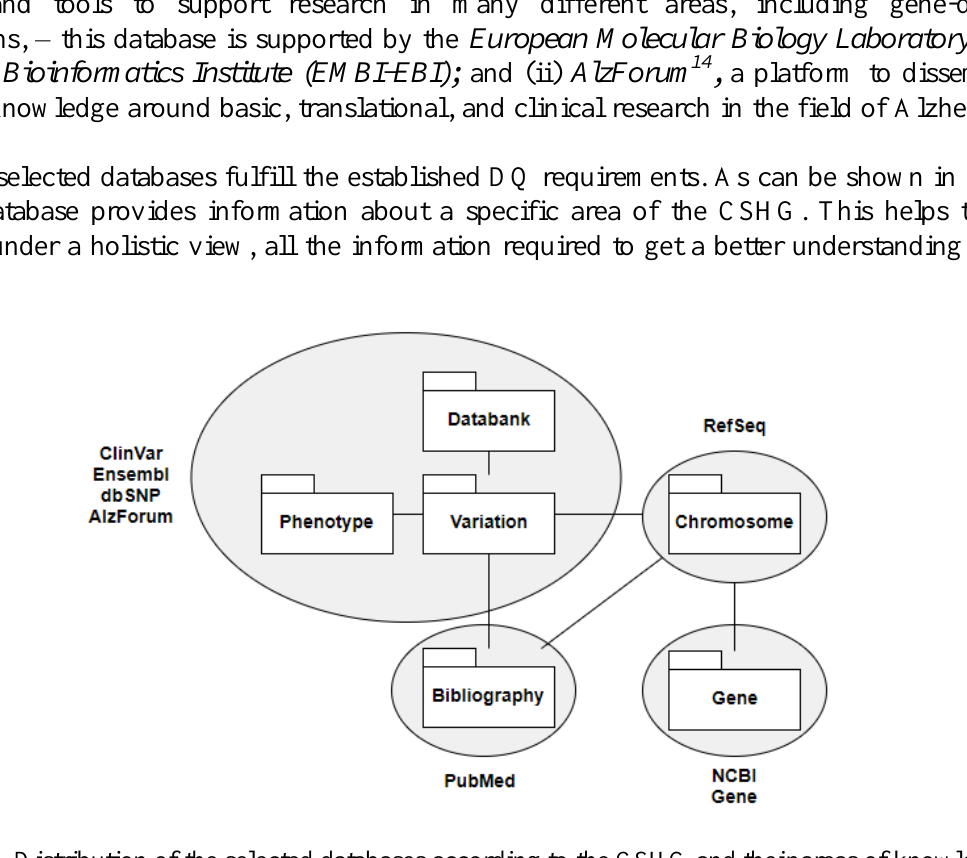
Figure 6. Distribution of the selected databases according to the CSHG and their areas of knowledge Some of the reasons why the other databases were excluded are: inactivity of the repository (e.g. AD&FTDMDB) , lack of revision from experts (SNPedia) or not enough data about the evidence that supports the relationship between the variation and the disease. LitVar is a special case, due to the fact that it is a useful database supported by NCBI; but it is still under development and, currently, the available release is a BETA version. This affects the believability of the information